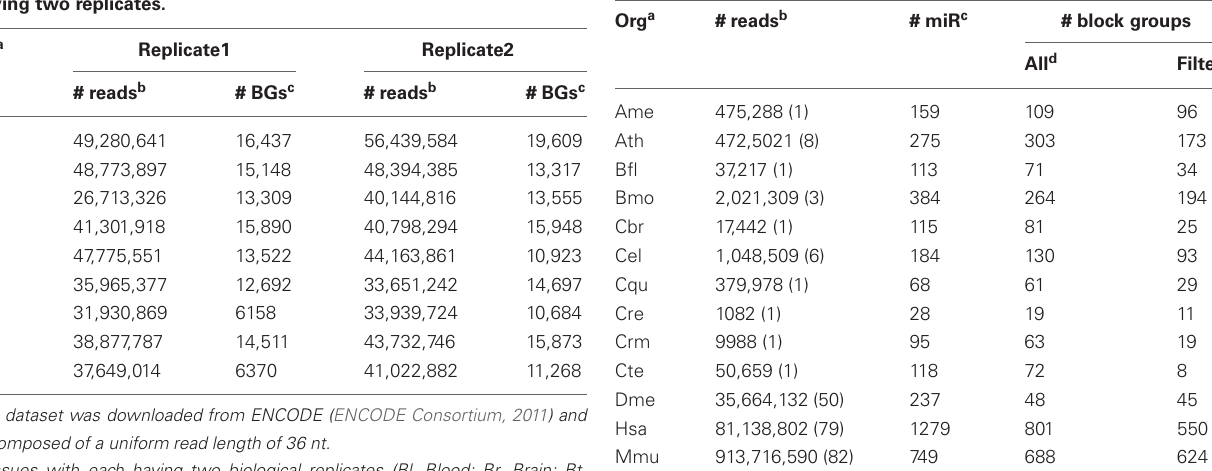
Table 3 | miRBase dataset is comprised of short-reads mapped to 4862 distinct microRNAs from 20